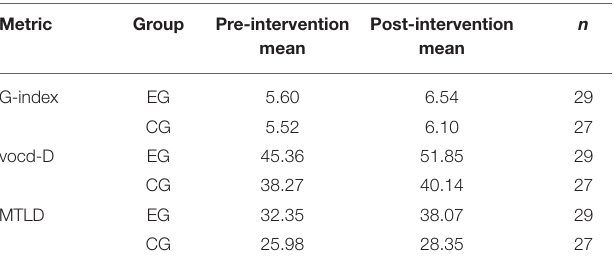
Frontiers in Psychology |